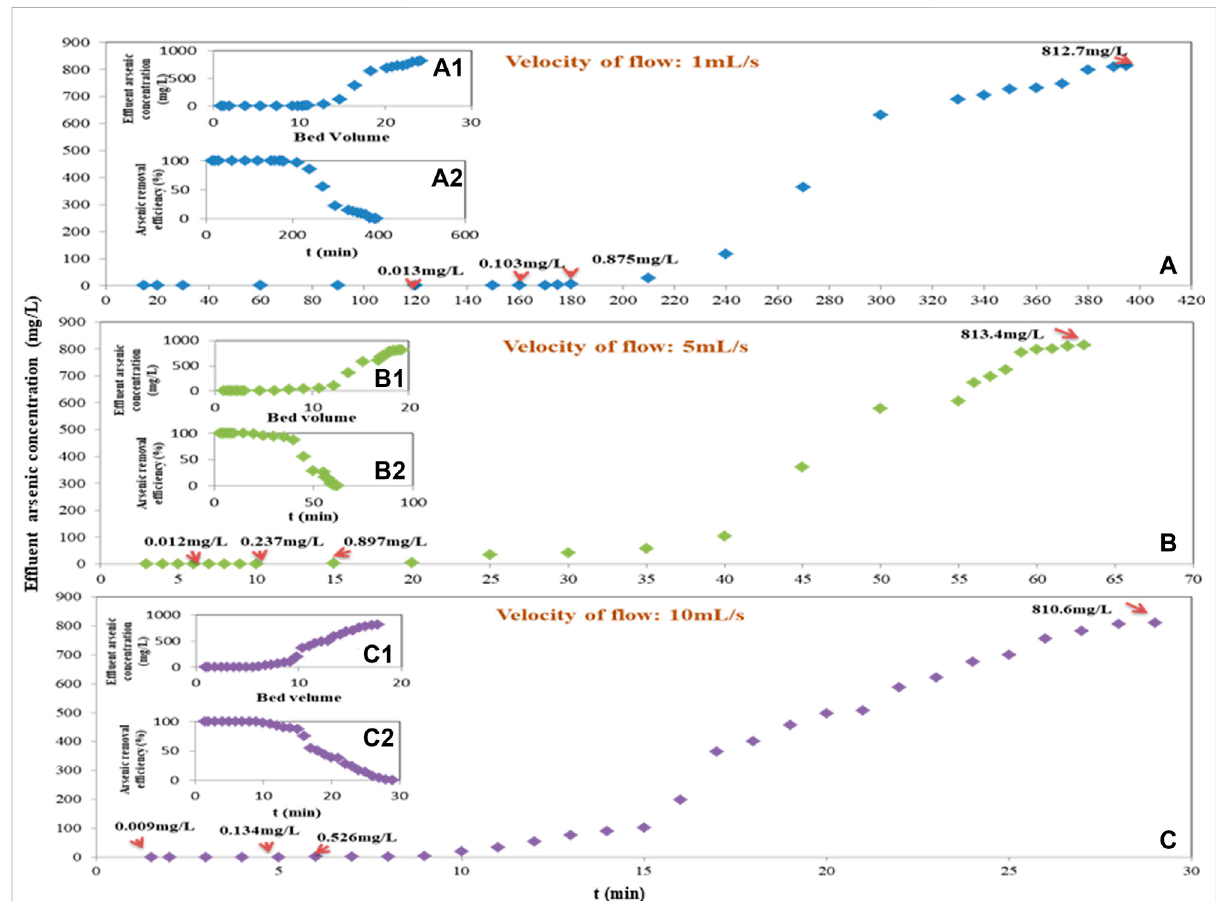
FIGURE 2 Adsorptioncolumnexperimentsonthelabscale[A,B,andCcurveofbreakthrough. (A1) , (B1) ,and (C1) curveofbedvolume. (A2) , (B2) ,and (C2) curve of arsenic-removal ef fi ciency. The velocity of fl ow was 1.0, 5.0, and 10.0